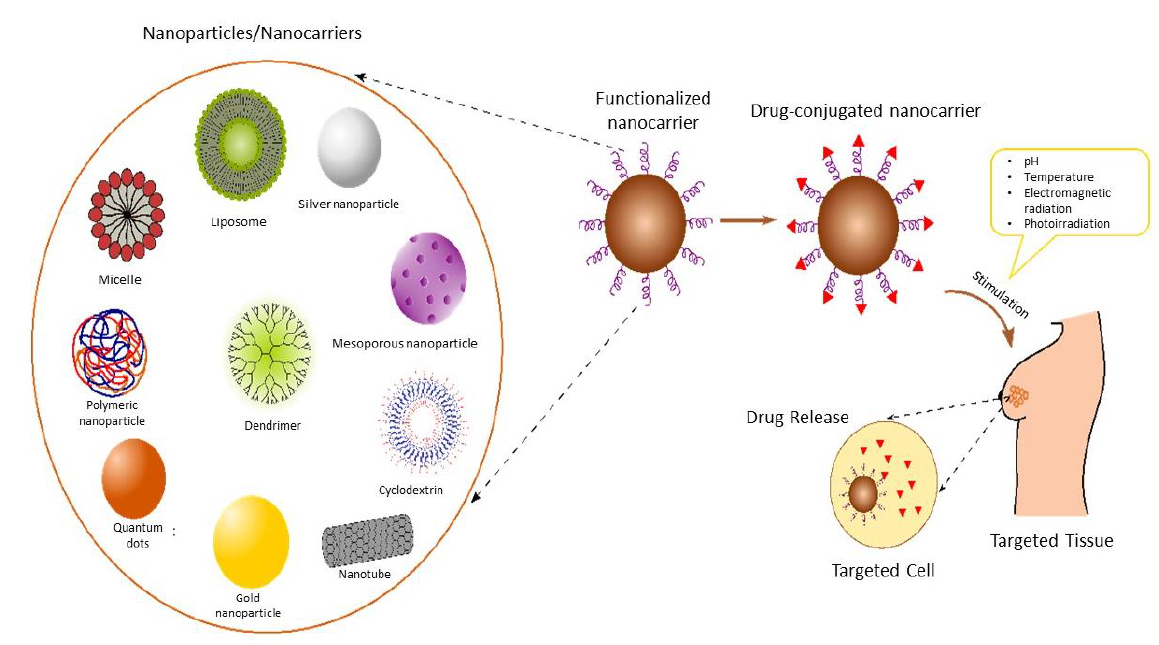
Figure 3. Nanotechnology-based approaches for TNBC treatment.